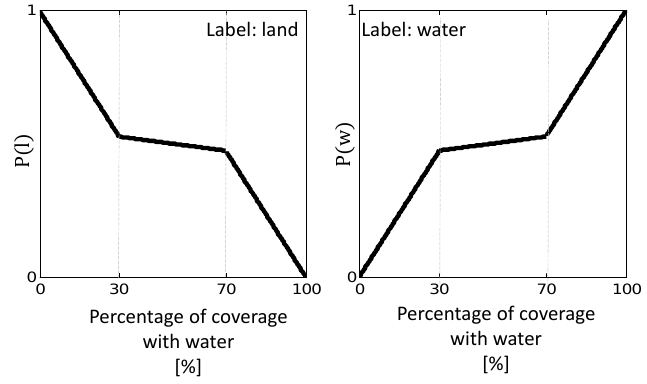
Figure 8. Functions that define the probability of assigning labels regarding long term behavior of the